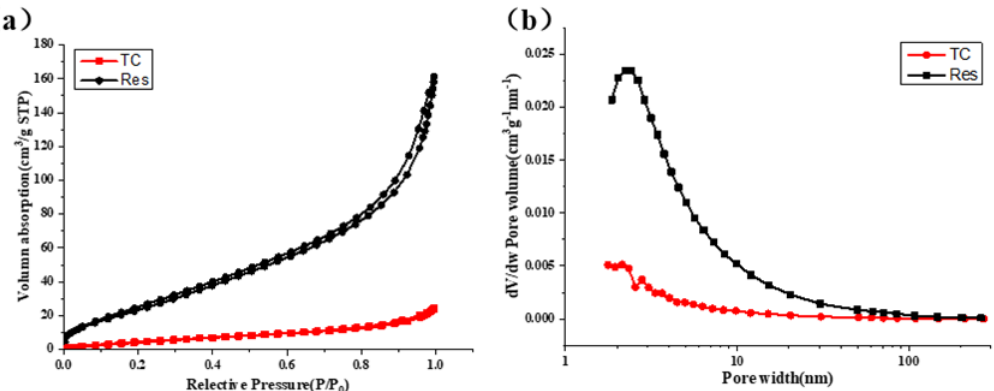
Figure 3. ( a ) Nitrogen adsorption-desorption isotherms of TC and Res. ( b ) The derivative pore size distribution curves for the TC and Res.